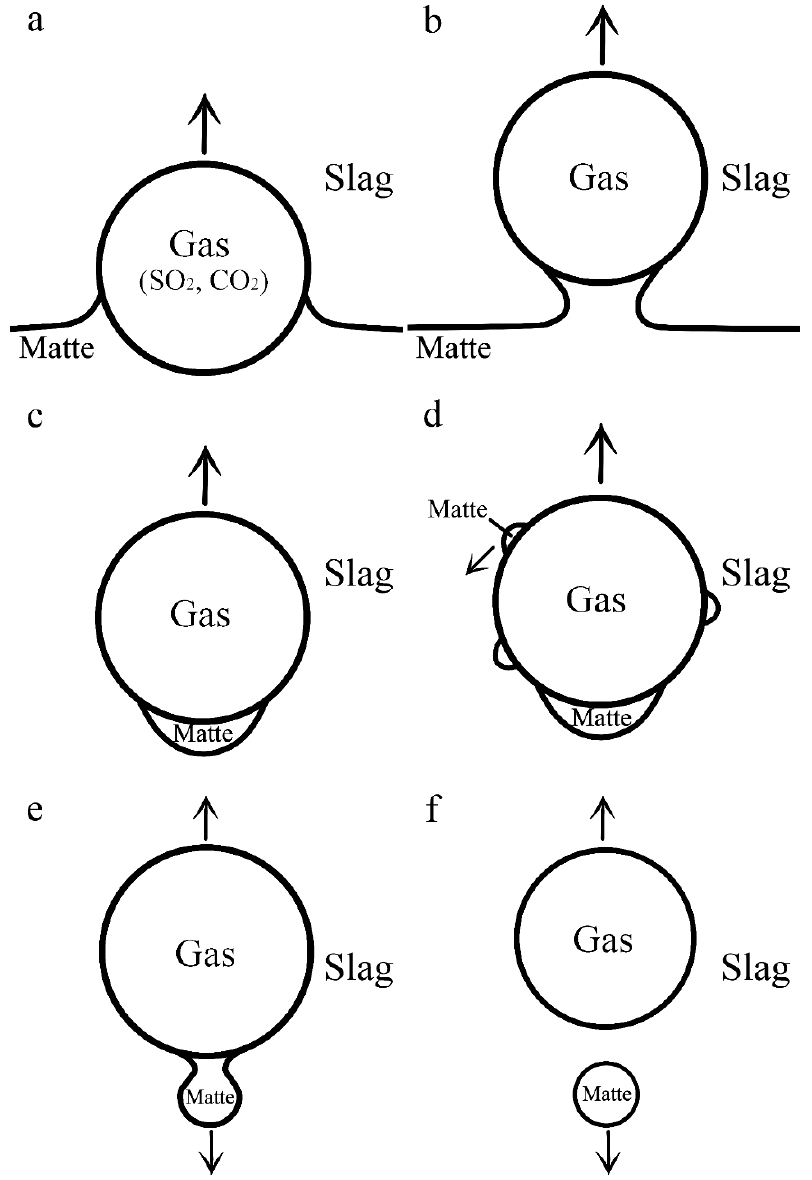
Figure 5. Stages of passage of a gas bubble through the matte–slag interface: ( a ) exit of a gas bubble to the matte–slag interface; ( b ) transition of a gas bubble through the matte–slag interface; ( c ) floating up of a gas bubble with a sulfide drop; ( d ) collection by the gas bubble of other dispersed matte droplets encountered on its way; ( e ) separation of the enlarged sulfide droplet from the gas bubble; ( f ) deposition of a sulfide droplet and floating of a gas bubble. Table 3. Calculation data.